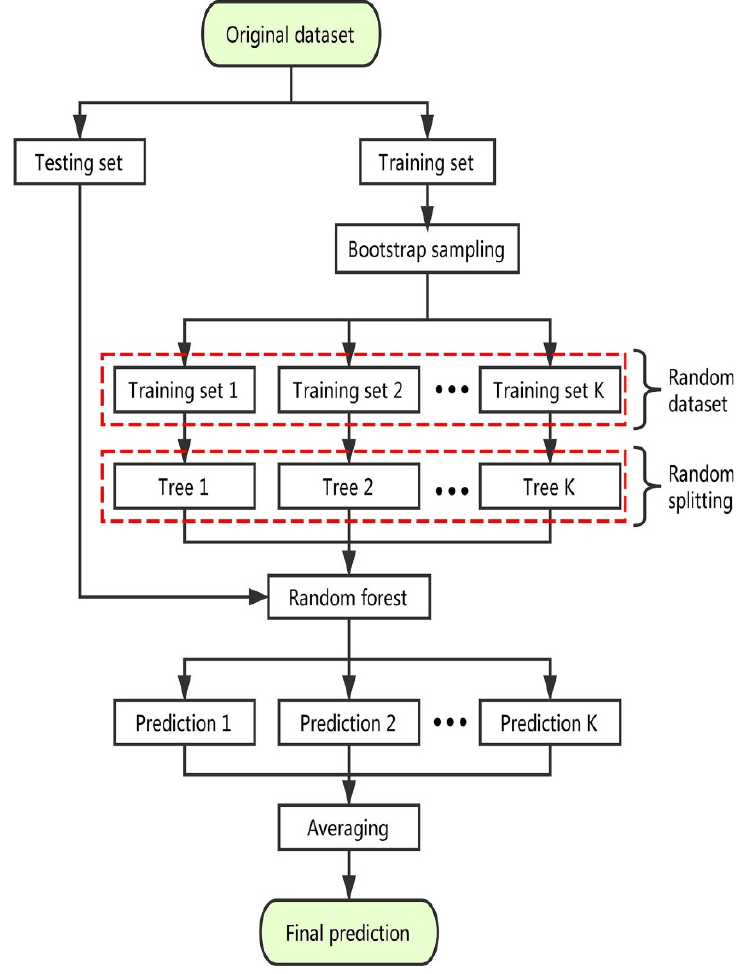
Figure 5. Schematic representation of the random forest technique [45] .